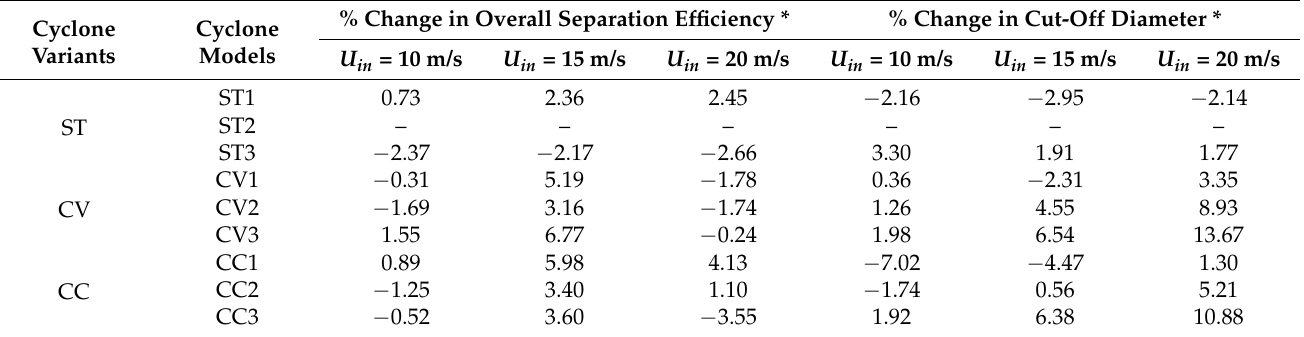
Table 3. Percent change in overall separation efficiency and cut-off diameter at different U in